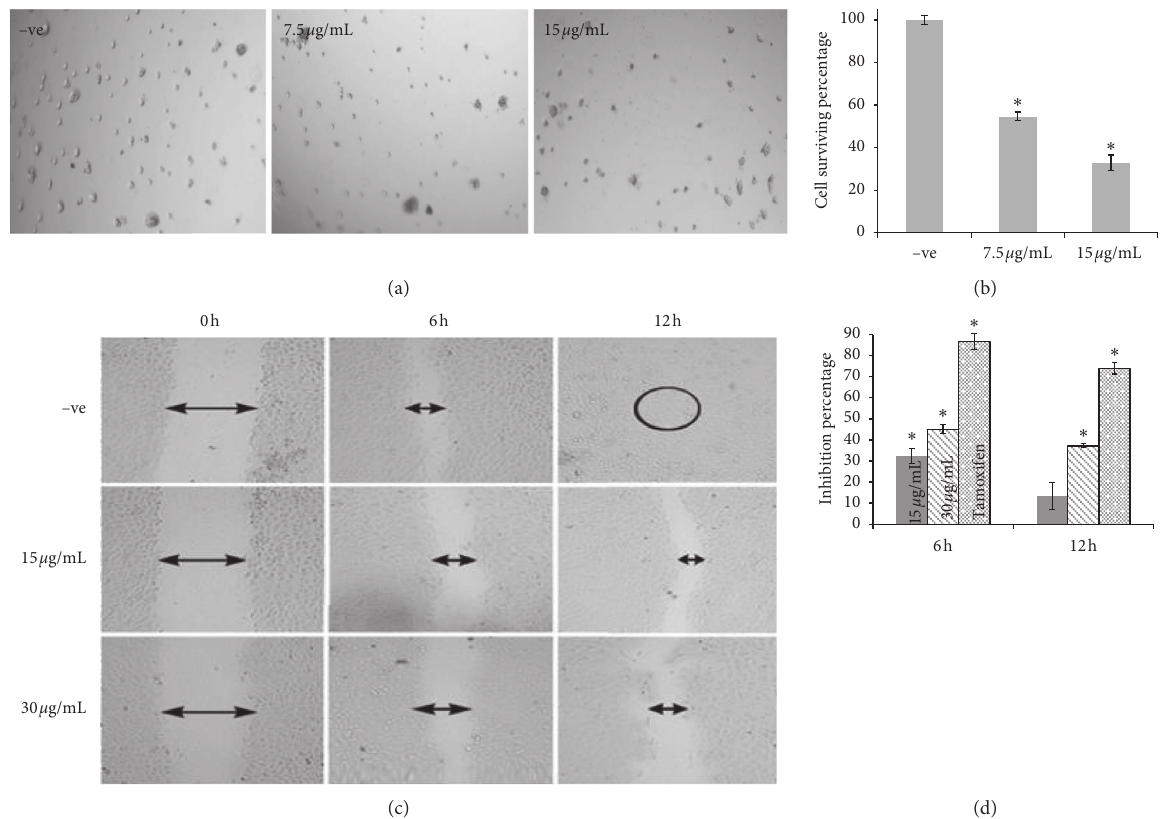
Figure 4: (a) Invasion assay of MCF-7 cells in matrigel basement. Cells were treated by ethanol ( − ve) or EHX at different concentrations. Magnification is 4x. (b) Percentage of cell surviving in invasion assay. Values are mean ± SD. ∗ p < 0.05. (c) Cell migration assay of MCF-7. Cells were treated by ethanol for negative control ( − ve) or EHX at different concentrations. Wound healing was observed at time points 0, 6, and 12hours. ImageJ software was used to measure the wound size. Magnification is 4x. (d) Percentage of inhibition of MCF-7cells’ migration after 6 and 12hours of treatment. Tamoxifen (10 μ g/mL) was used as a positive control. Values are mean ± SD. ∗ p <